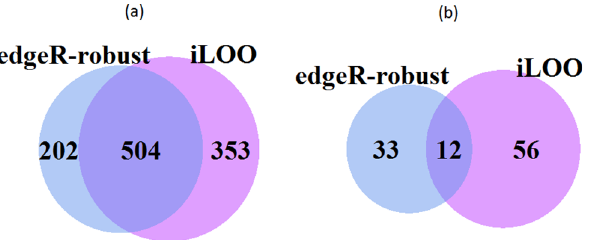
Fig 2. Venn diagram of the number of features with outliers detected by iLOO and edgeR-robust . The totals provided present the number of (a) single outlier features and (b) features with two detected outliers identified by iLOO and edgeR-robust in the control group of rat RNA-seq data.